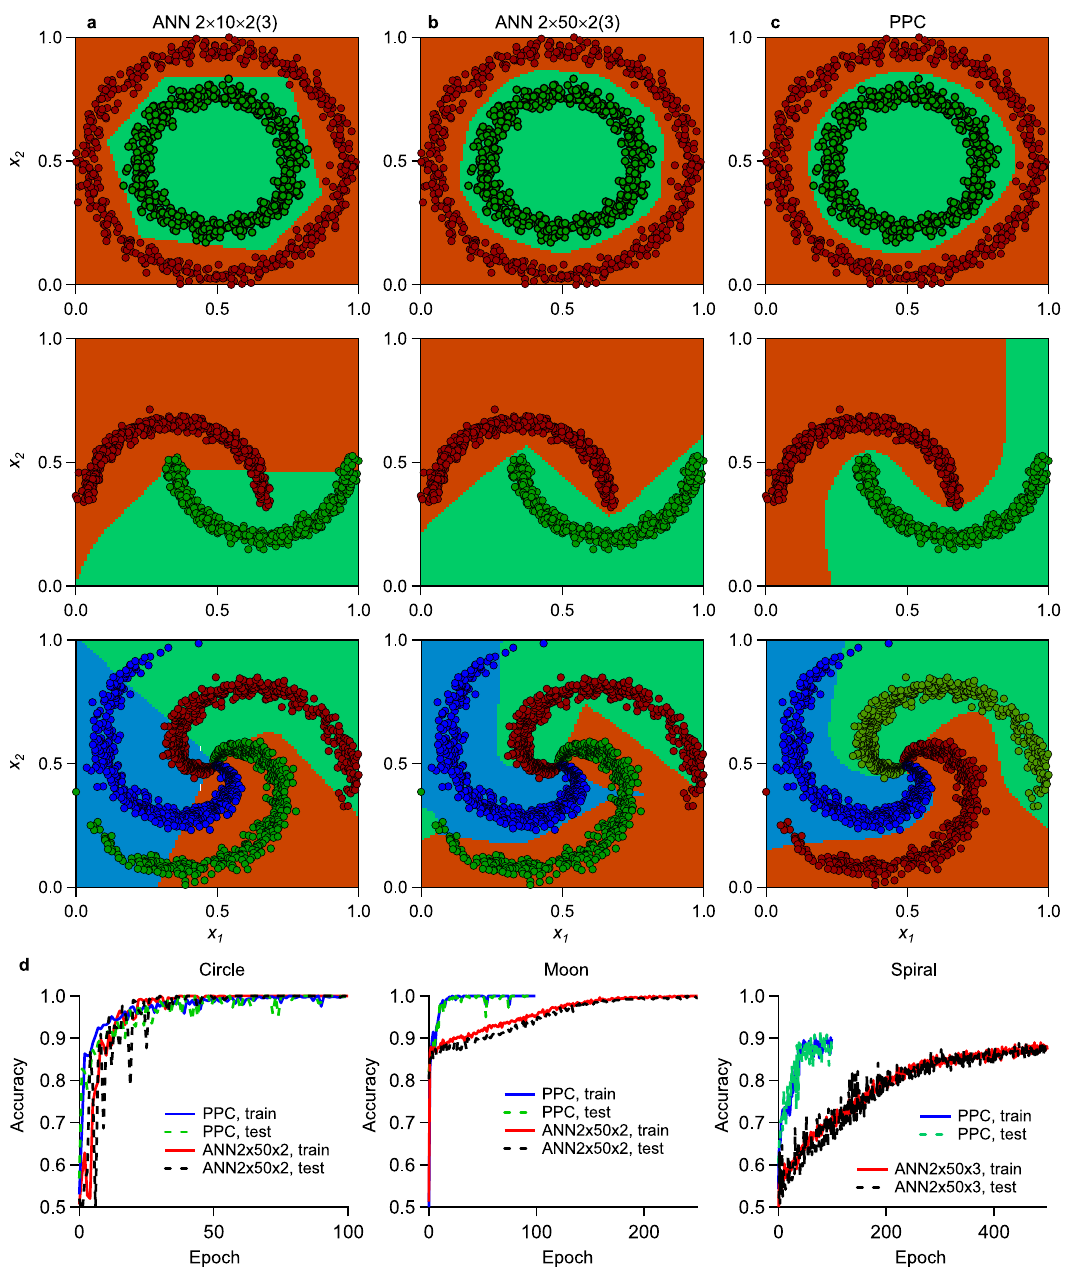
Fig. 6 Comparison between ANN (arti fi cial neural networks in form of multilayer perceptron) and PPC (projection-based photonic classi fi er) for classifying the nonlinear datasets: Circle, Moon, and Spiral. Predicted nonlinear boundary for the Circle, Moon, and Spiral datasets in each column of sub fi gures: a ANN with 10 middle nodes; b ANN with 50 middle nodes; c PPC. d Comparison on the training curves of accuracy between the PPC and ANN with 50 middle nodes. The region of x 1 , x 2 ∈ [0,1) is discretized in a step of 0.01. The data are normalized to π for the PPC. In ( a – c ), the colors orange, green, and blue in data points and regions represent the classes 0, 1, 2, respectively. The ANN adopts three-layer models: input (2 nodes), middle (10 or 50 nonlinear neuron nodes), and output (2 nodes for the Circle and Moon, 3 nodes for the Spiral), denoted by ANN 2 × 10 × 2(3). The PPC has 43 parameters in total and the ports 1, 3, 5 are dropped out as the output vector to correspond to the three classes 0, 1, 2. The ANN has 252 and 303 parameters for 2 × 50 × 2 and 2 × 50 × 3, respectively, and uses ReLU (recti fi ed linear unit) activation functions for the middle layer and softmax output layer. For the Moon and Circle, 1000 samples in total, 600 for training, 400 for testing; for the Spiral, 1500 samples in total, 900 for training, 600 for testing. All training and testing data plotted in ( a – c ), are uploaded and both training and testing accuracies are shown in ( d ). Source data are provided as a Source Data fi